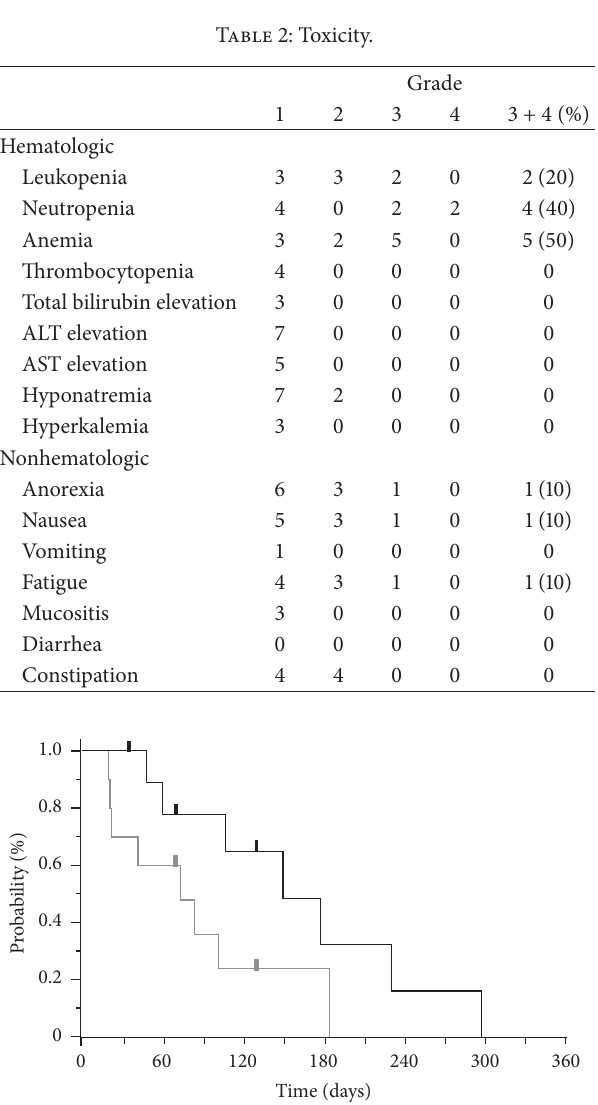
Figure 1: The median PFS and OS of study